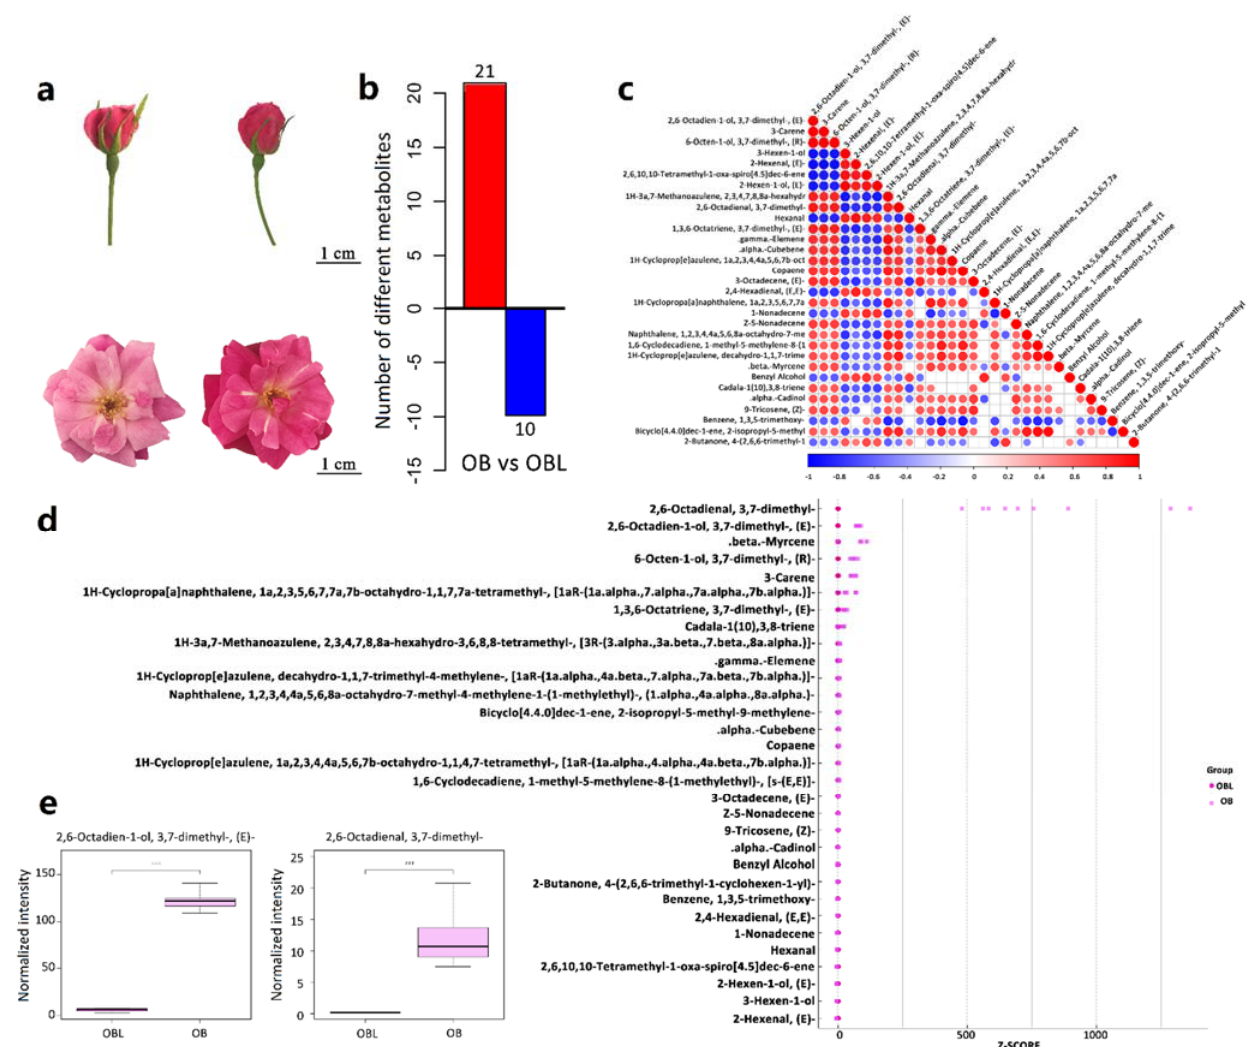
Figure 1. Analysis of differentially abundant volatile compounds between OB and OBL flowers by GC–MS. ( a ) Representative stage 5 flowers ( top ) from ‘Old Blush’ (OB, left ) and ‘Old Blush’-like (OBL, right ) used for RNA-seq and GC–MS analyses. Completely open flowers are shown as well ( bottom ). Scale bars, 1 cm. ( b ) Number of differentially abundant volatiles detected by GC–MS between OB and OBL. ( c ) Correlation matrix between the concentrations of various volatiles among samples. The extent of correlation follows the indicated scale from − 1 (blue, negative correlation) to +1 (red, positive correlation). The full names of all volatiles are shown in ( d ). ( d ) Significant differentially abundant compounds, identified based on their Z-score, reordered from ( c ) based on decreasing Log2 (Fold-change between OB and OBL). OB and OBL are shown as pink circles and darker pink circles. ( e ) Normalized abundance of geraniol (2,6-octadien-1-ol, 3,7-dimethyl-, ( E ) − ) and citral (2,6-octadienal, 3,7-dimethyl-), shown as